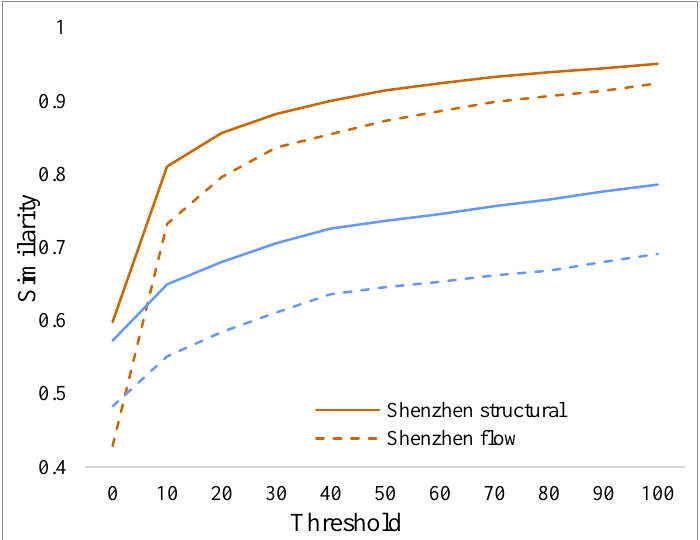
Figure 9. The similarity changes with the threshold. Table 3. Structural similarity of the OD matrixes in Shenzhen.